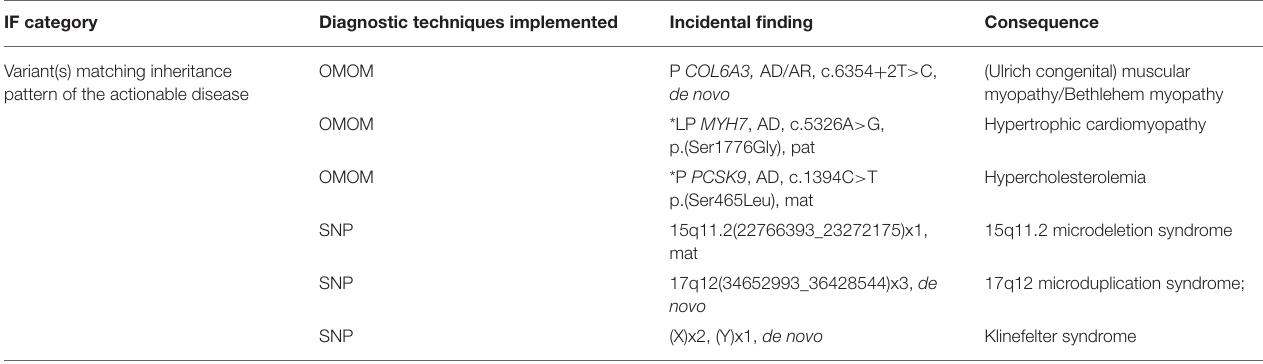
TABLE 5 | Reported incidental findings. IF